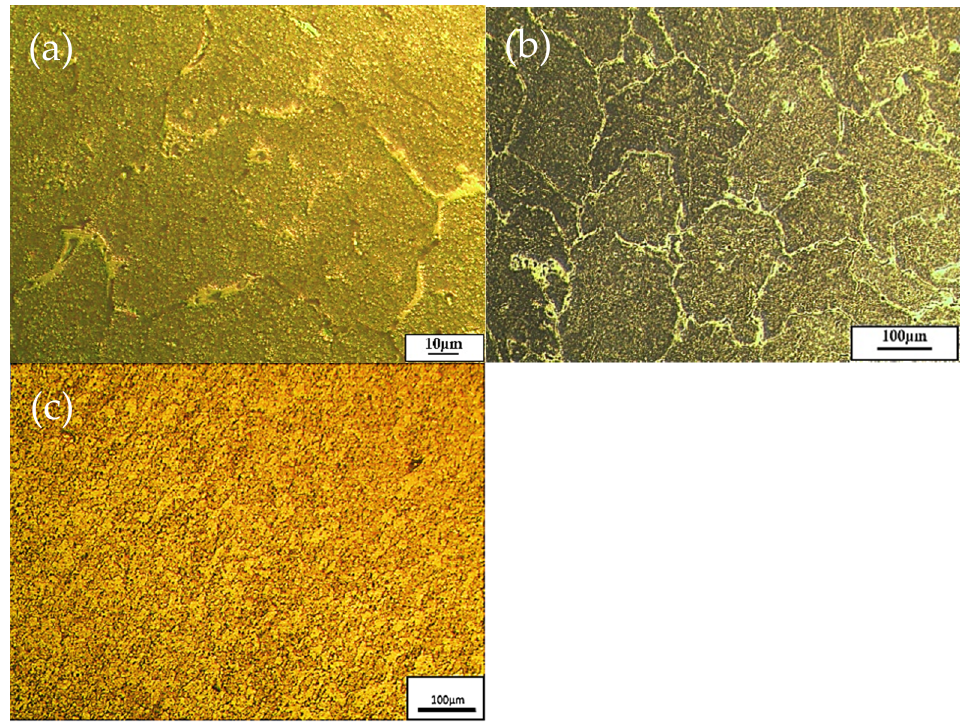
Figure 17. Microstructure of AA 6063 substrate at magnification of ( a ) 50×, ( b ) 10×, and ( c ) stir zone (SZ) at 10×.